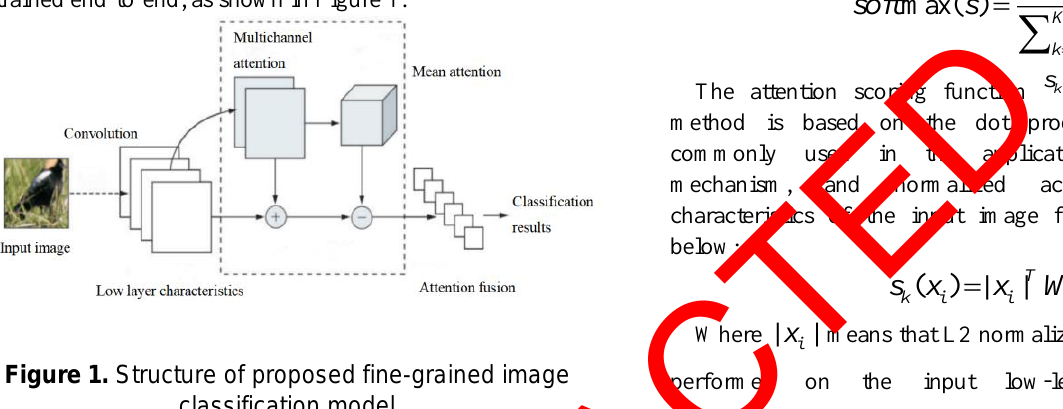
Figure 1. Structure of proposed fine-grained image classification